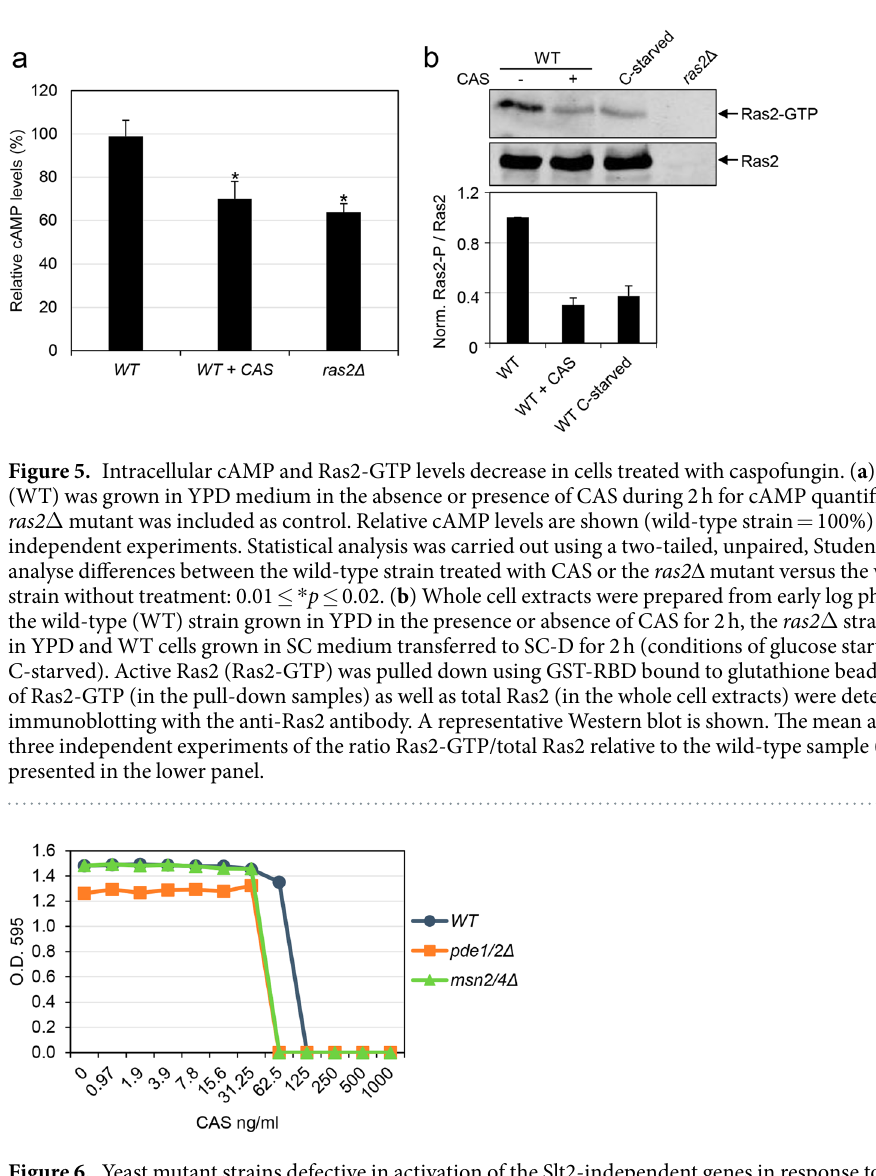
Figure 6. Yeast mutant strains defective in activation of the Slt2-independent genes in response to CAS are sensitive to this compound. CAS sensitivity of the indicated yeast strains was performed in a 96-well microtiter plate assay with CAS concentrations ranging from 1000 to 1 ng/ml. Each well was inoculated with ~10 4 cells from an exponentially growing culture. Plates were incubated for 48 h at 30 °C, and cell growth was determined by measuring absorbance at 595 nm. The graph corresponds to a representative